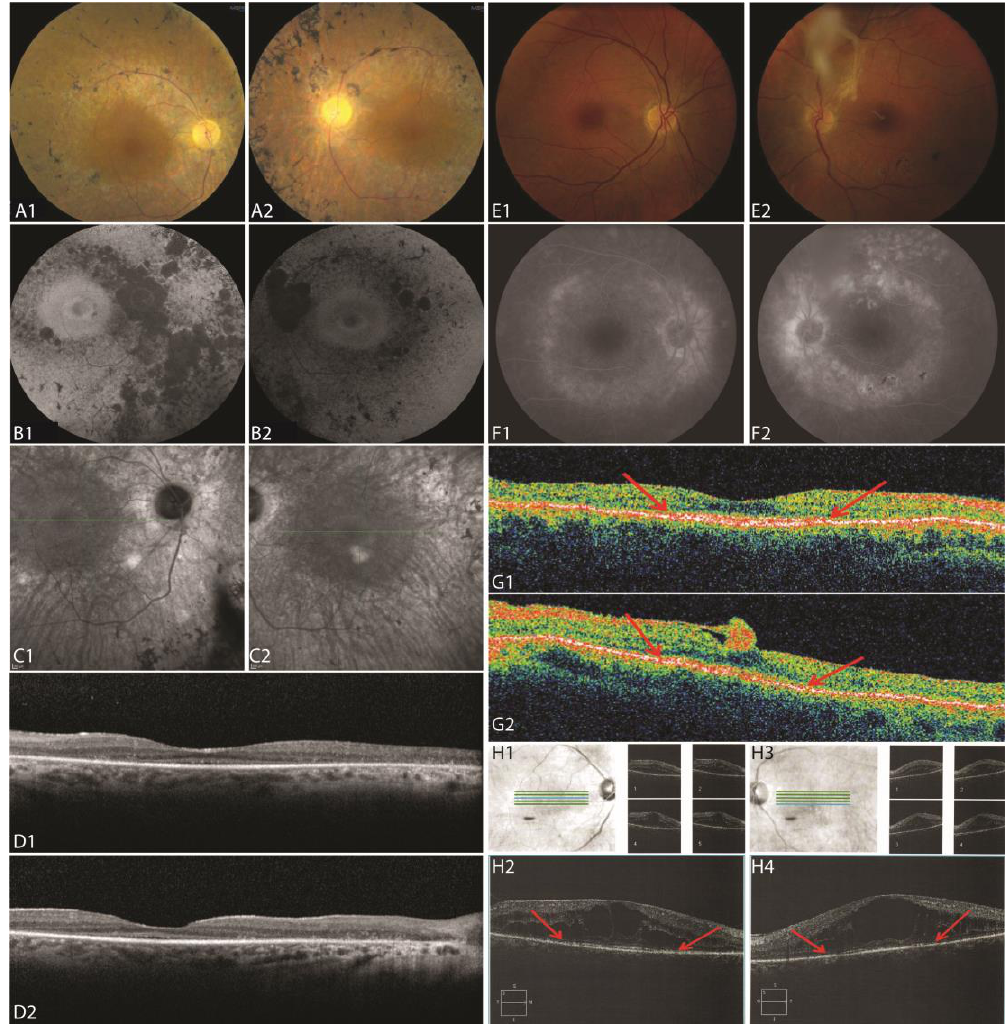
Figure 3. Retinal Imaging. ( A – D ) Fundus imaging of the right ( A1 – D1 ) and left ( A2 – D2 ) eye of II:1 at age 60. ( A1 – A2 ) Color fundus photos show disc pallor, retinal vascular attenuation and bone spicule pigmentary change along the arcades. ( B1 – B2 ) Fundus autofluorescence shows a ring of increased autofluorescence in the macula and nummular loss of autofluorescence along the arcades in both eyes. ( C1 – C2 ) Infrared fundus images show retinal pigment epithelium (RPE) loss along the arcades, vascular attenuation, and bone spicules in both eyes. ( D1 – D2 ) Macular horizontal spectral domain optical coherence tomography (SD-OCT) scans show loss of outer retinal layers throughout the macula with preserved outer nuclear layer (ONL), external limiting membrane (ELM), and inner segments (IS) at the fovea in both eyes. ( E – G ) Fundus imaging of the right ( E1 – G1 ) and left ( E2 – G2 ) eye of II:3 at age 47. ( E1 – E2 ) Color fundus photos of the right eye show pigment mottling along the arcades ( E1 ), and photos of the left eye shows a dense epiretinal membrane with overlying vitreous opacity and pigmentary changes along the inferotemporal arcade ( E2 ). ( F1 – F2 ) Fluorescein angiography shows staining of the optic nerve and areas of RPE atrophy in late frames. ( G1 – G2 ) SD-OCT scans show a preserved ONL, ELM, and inner segment/outer segment (IS/OS) junction band at the fovea in both eyes; the edges of the IS/OS junction band are demarcated by red arrows. ( H1 – H4 ) Infrared fundus images and SD-OCT B-scans of the right ( H1 – H2 ) and left ( H3 – H4 ) of patient II:4 at age 58. Blue lines indicate location of SD-OCT B-scans (bottom) and green lines show locations of smaller scans showing cystoid macular edema with large foveal cysts and IS/OS junction band loss; red arrows indicate the edges of the IS/OS junction